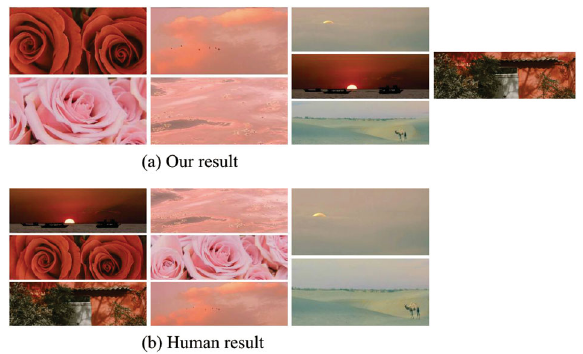
Fig. 12 Special case of our method. Our result has low consistency with the human